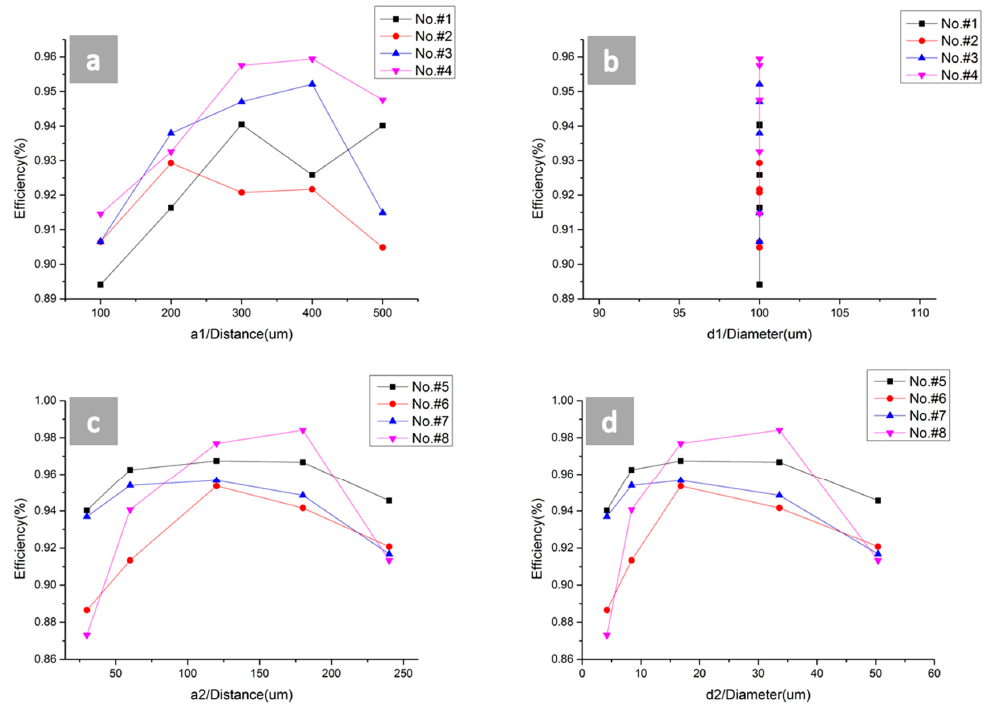
Figure 11. The absorption efficiency of the micro-nano hybrid structures obtained for different tip and pit sizes. ( a ) The relational graph between the efficiency and diameter of the tips (first designed trench size) and ( b ) the relational graph between the efficiency and depth of the tips (first designed trench size). ( c ) The relational graph between the efficiency and diameter of the pits (first designed trench size) and ( d ) the relational graph between the efficiency and depth of the pits (first designed trench size).